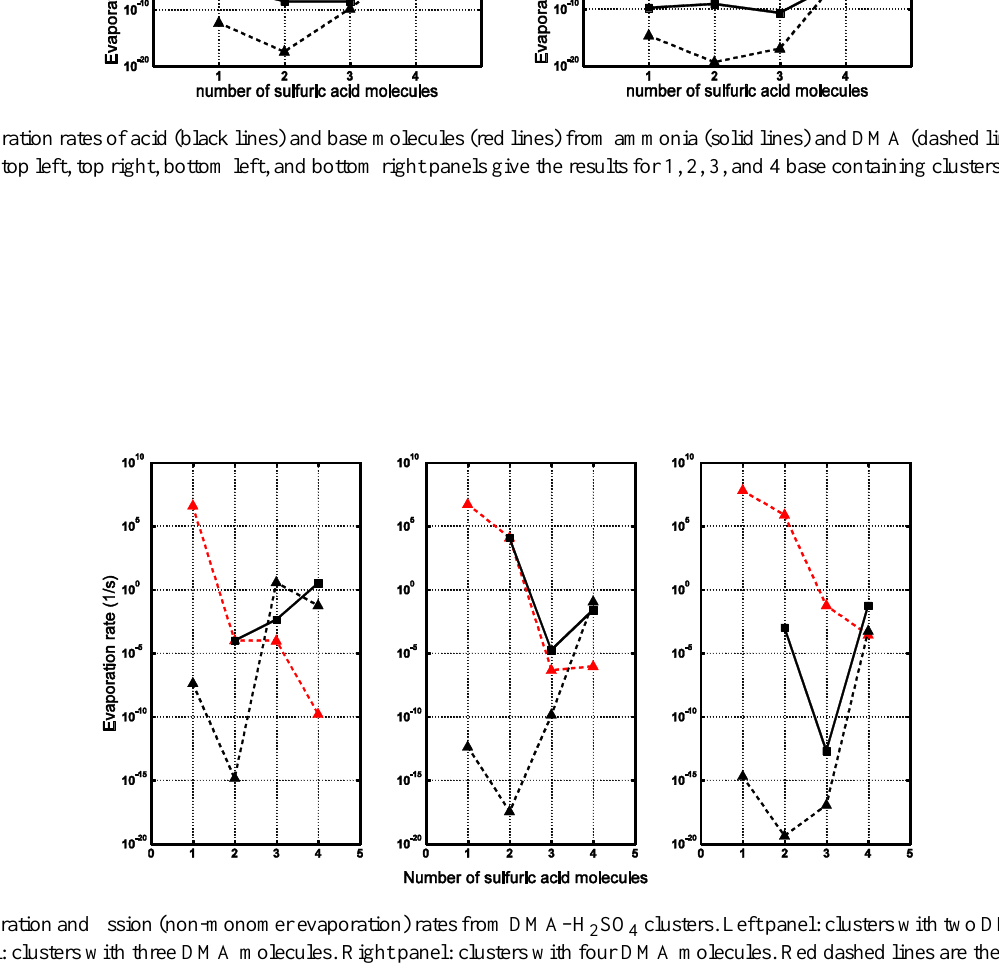
Fig. 4. Evaporation rates of different clusters versus number of sulfuric acid molecules in the cluster. The blue, black, red, and green lines represent clusters containing one, two, three, and four base molecules, respectively. The left panel is for ammonia clusters, while the right for those containing DMA.